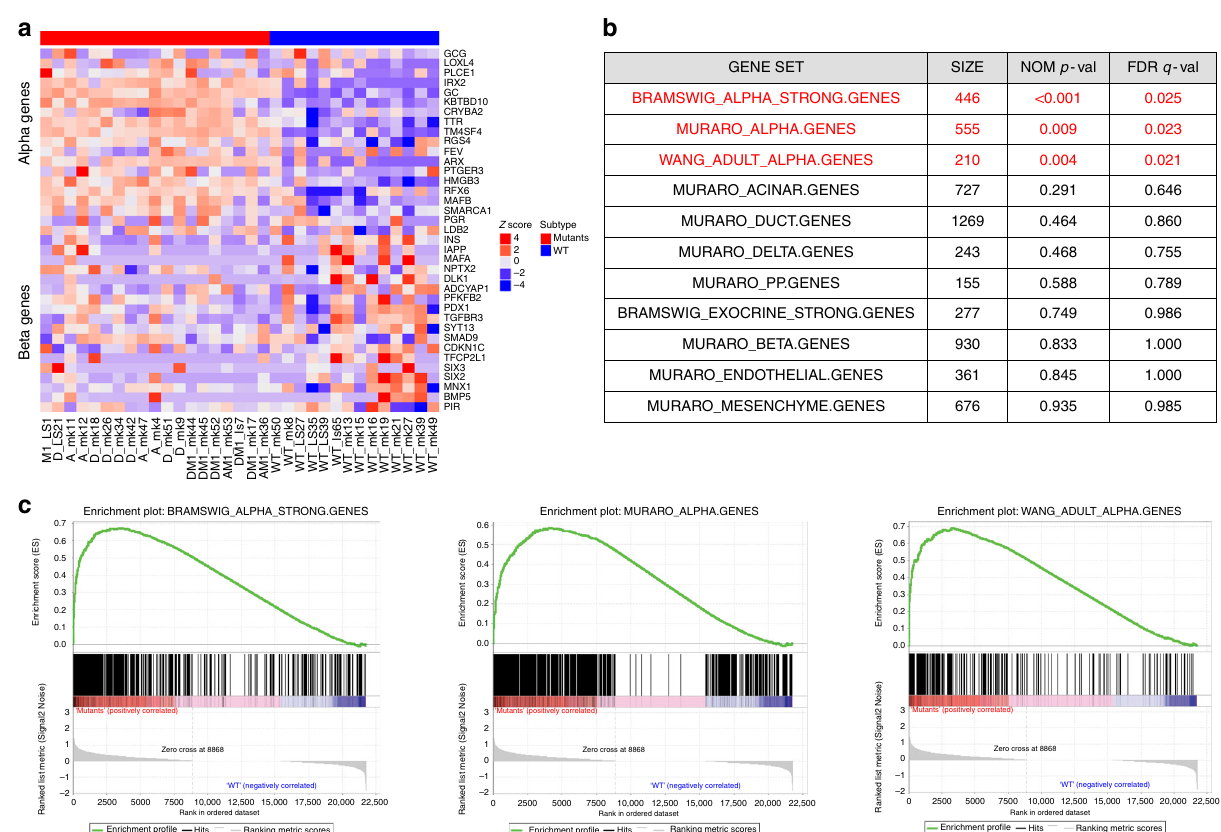
Fig. 4 A-D-M mutant PanNETs with alpha-cell signature. a Heatmap of gene expression for top 20 alpha and beta cell-speci fi c genes from Muraro et al. 11 revealed alpha cell speci fi c genes are highly expressed in A-D-M mutant panNETs. A-D-M WT panNETs are more heterogeneous in gene expression but some show high beta cell speci fi c gene expression. Red color represents higher correlation with alpha cell speci fi c genes. b Gene set enrichment analysis show A-D-M mutant PanNETs to be enriched for expression of alpha cell speci fi c genes. Pancreas cell type (alpha, beta, delta, PP, acinar, ductal) gene signatures were obtained from three different published dataset to access enrichment of cell type signatures in A-D-M mutant vs A-D-M WT PanNETs. Table represents GSEA results where size is the number of genes in gene set. All alpha cell gene sets (from three different sources) are signi fi cantly enriched in A-D-M mutant panNETs (highlighted in red). No other cell types were enriched in A-D-M mutant or A-D-M WT panNETs. c GSEA plots of signi fi cant alpha cell signatures from Bramswig et al. 15 , Wang et al. 32 , and Muraro et al.